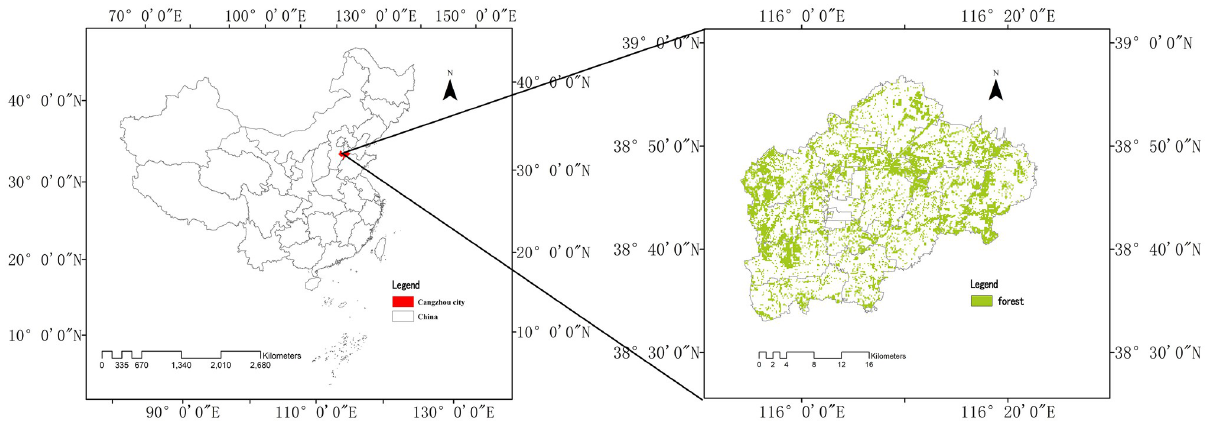
Fig 1. Location map of Renqiu